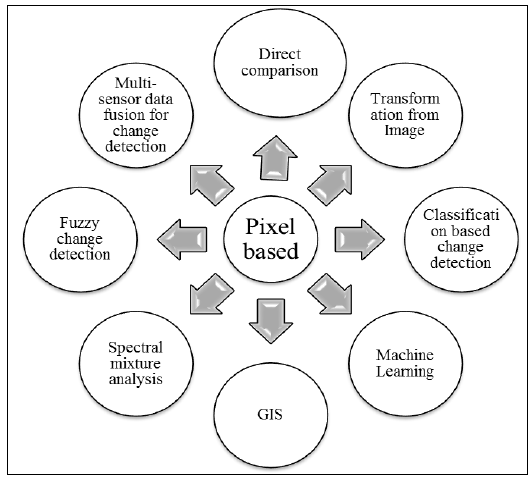
Figure 1, Overview of different pixel based change detection